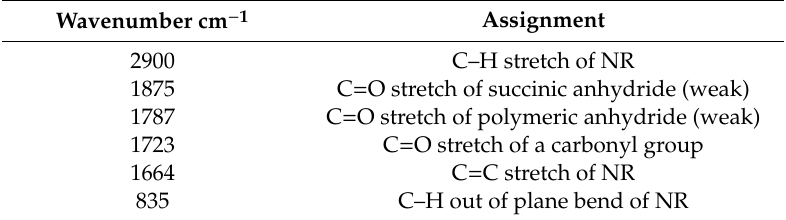
Figure 3. FTIR spectra of MNR prepared at various MA contents. NR, natural rubber; MNR, maleated natural rubber; MA, maleic anhydride. Table 3. The peaks and their assignments in spectra for NR and MNR.